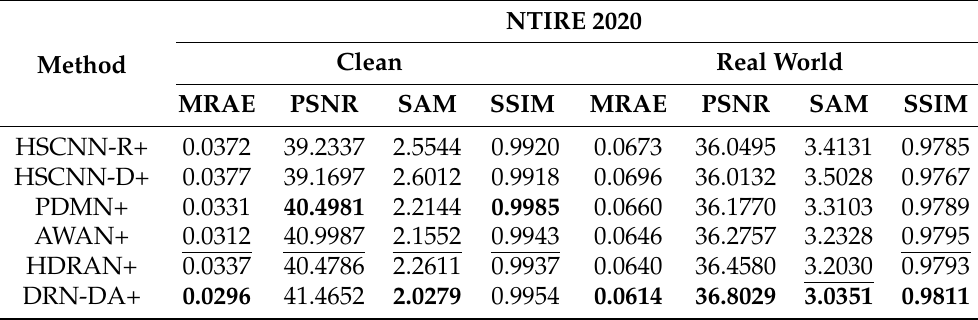
Table 4. Comparison between the proposed method and other state-of-the-art methods with the ensemble strategy based on the NTIRE 2020 data sets.